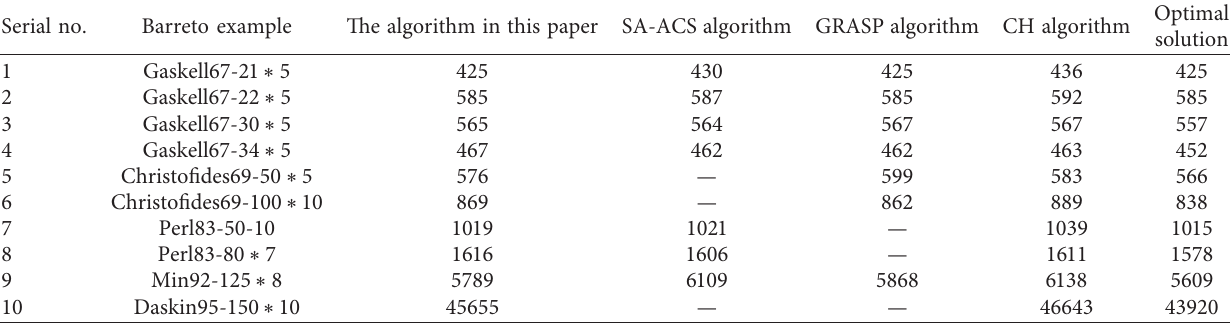
Table 2: Comparison of result sets of different algorithms.